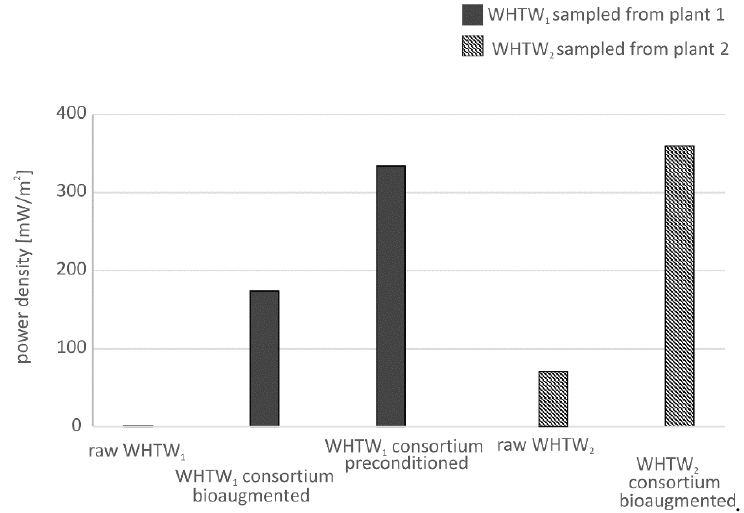
Figure 3. Summary of different power densities produced in MFCs fed WHTW.